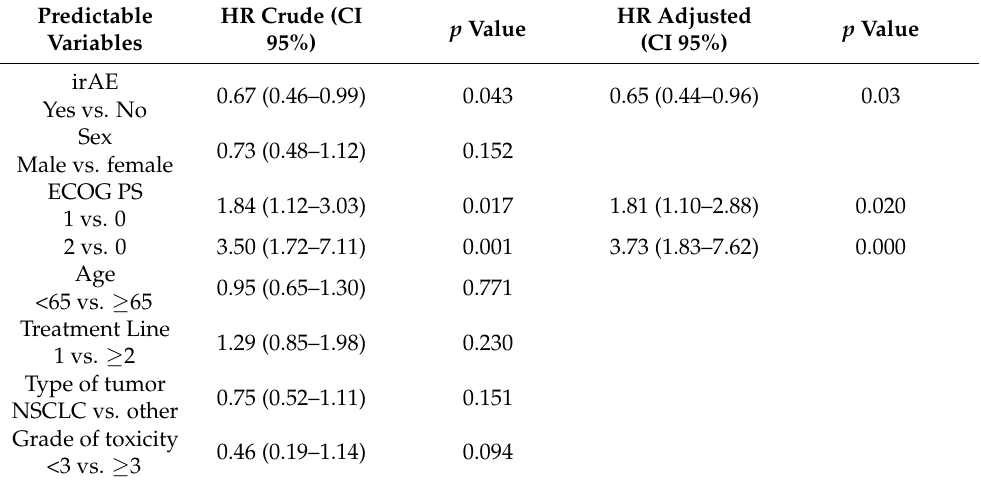
Table 3. Univariate and Multivariate cox proportional hazards regression analysis of the risk of